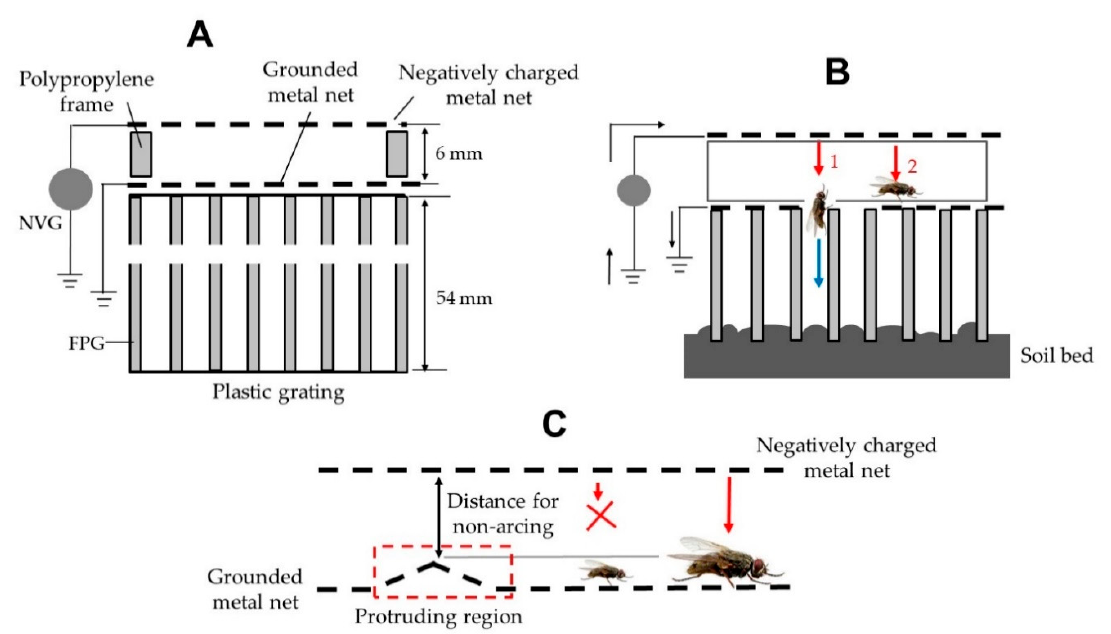
Figure 6. ( A ) Schematic representation of an arc-type soil cover system developed to kill insect pests that emerge from a soil bed. ( B ) Two-step arcing from the charged metal net to a fly that climbed along the wall of the grating and reached the electric field (red arrow 1) and a fly that clambered over the grounded metal net (red arrow 2) (cross-sectional view). The black arrow represents the direction of current flow, and the red arrow shows the electricity movement caused by arc discharge. The blue arrow represents the fall of an insect to the bottom of the grating after arc discharge exposure. ( C ) Successful and unsuccessful arcing to target flies based on their body size difference.